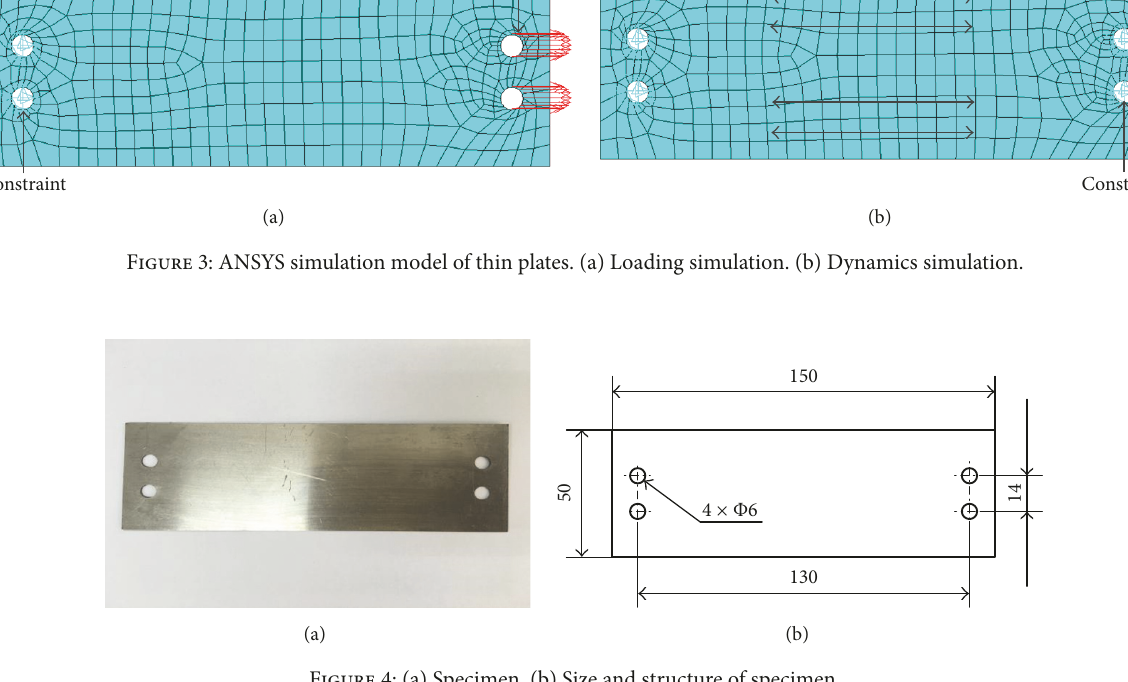
Figure 4: (a) Specimen. (b) Size and structure of